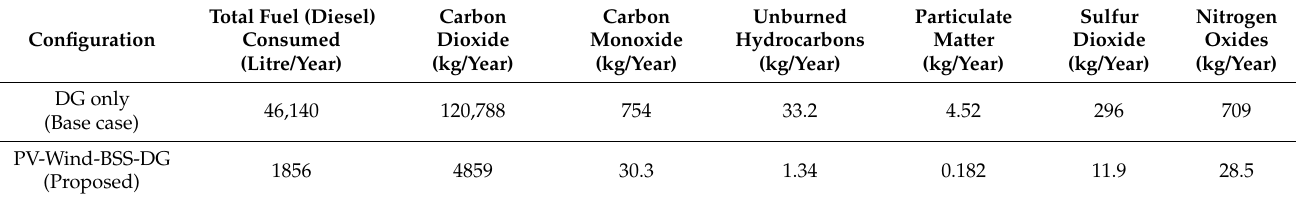
Table 9. Comparison of emission of pollutants from different